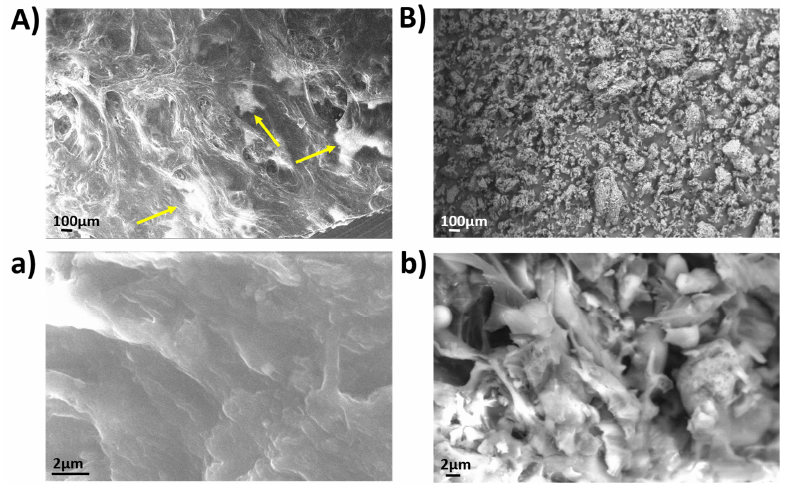
Figure 3. SEM images of the silk fibroin-based pad with PPP at different magnifications ( A , a ). SEM images of PPP at different magnifications ( B , b ).